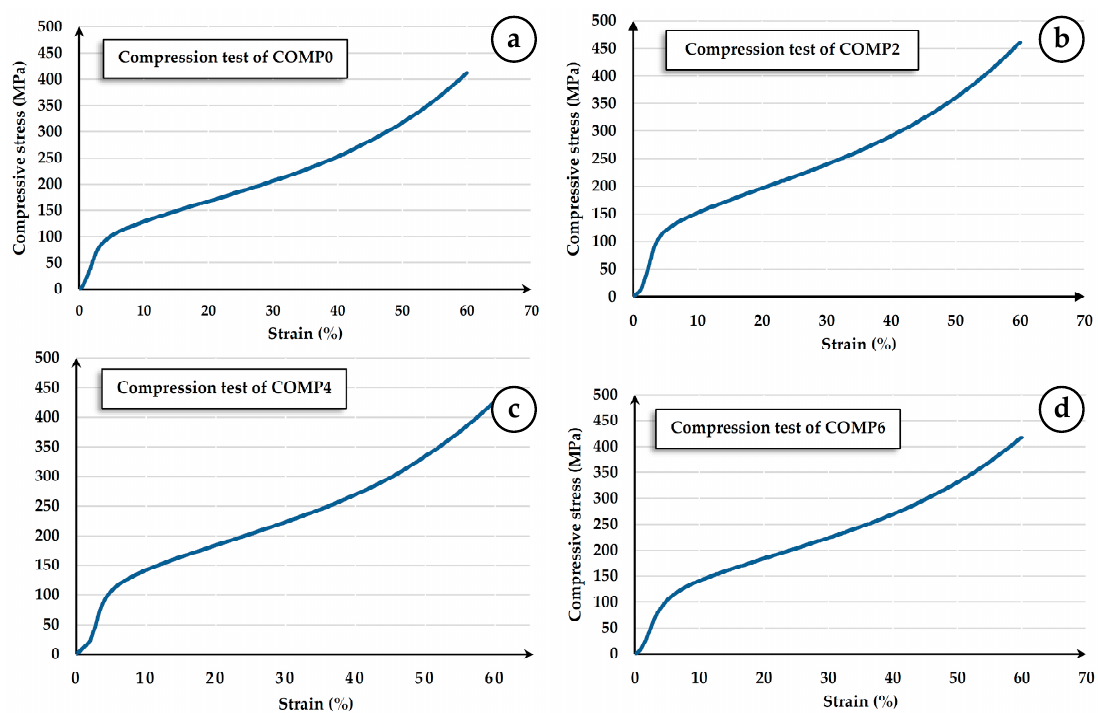
Figure 12. The compression strength (60% strain) behavior of the fabricated composites taken at room temperature and strain rate of 0.5 mm/min. ( a ) Tension test of COMP0; ( b ) Tension test of COMP2; ( c ) Tension test of COMP4; ( d ) Tension test of